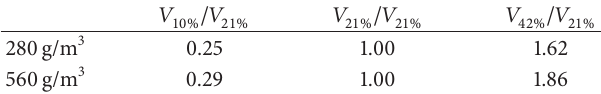
Table 4: Measured flame speed